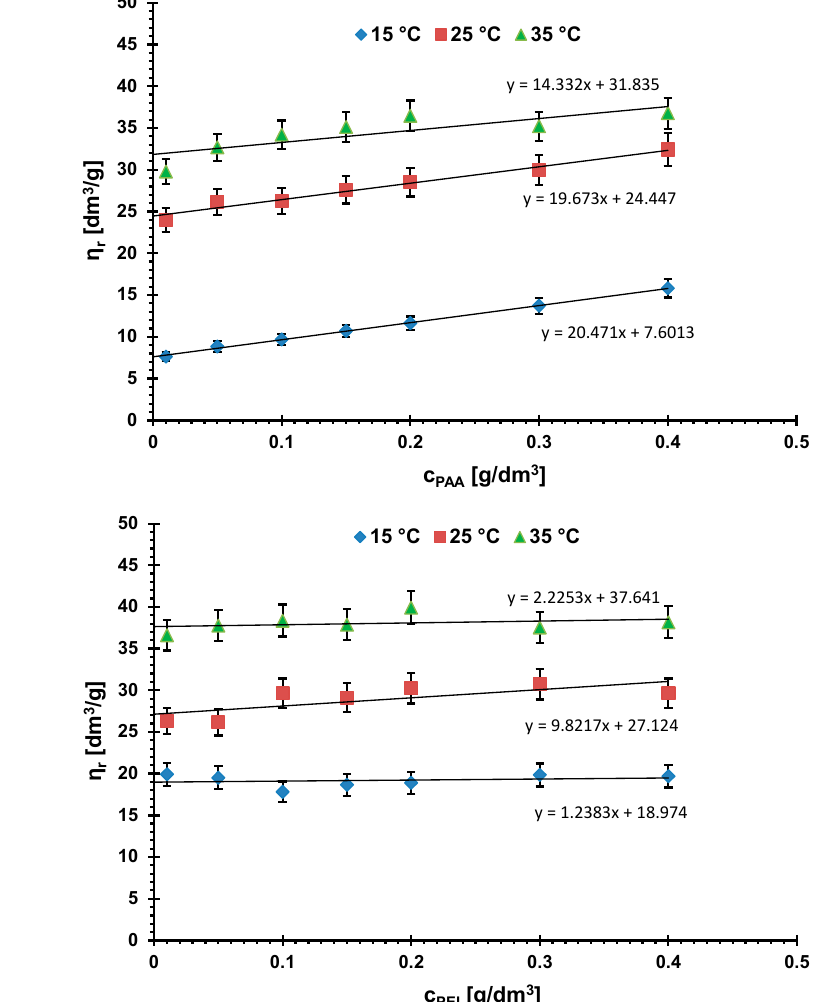
Figure 1. Intrinsic viscosities of ( a ) PAA and ( b ) PEI solutions as a function of their concentrations at different temperatures, pH 3.